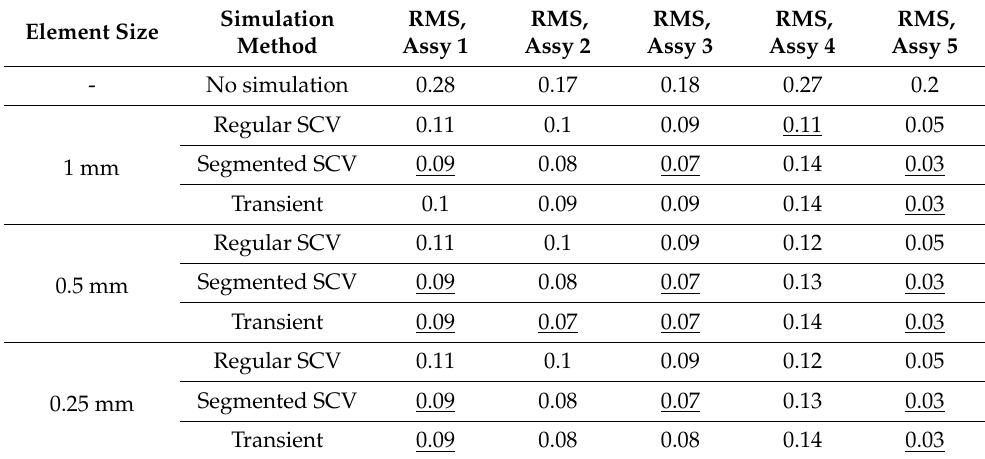
Table 1. RMS values for the five welded assemblies, sorted by different element sizes and simulation methods. The RMS value indicates the difference between the prediction from the welding simulation and the result from the real welding procedure. A perfect prediction would thus have an RMS value equal to zero.